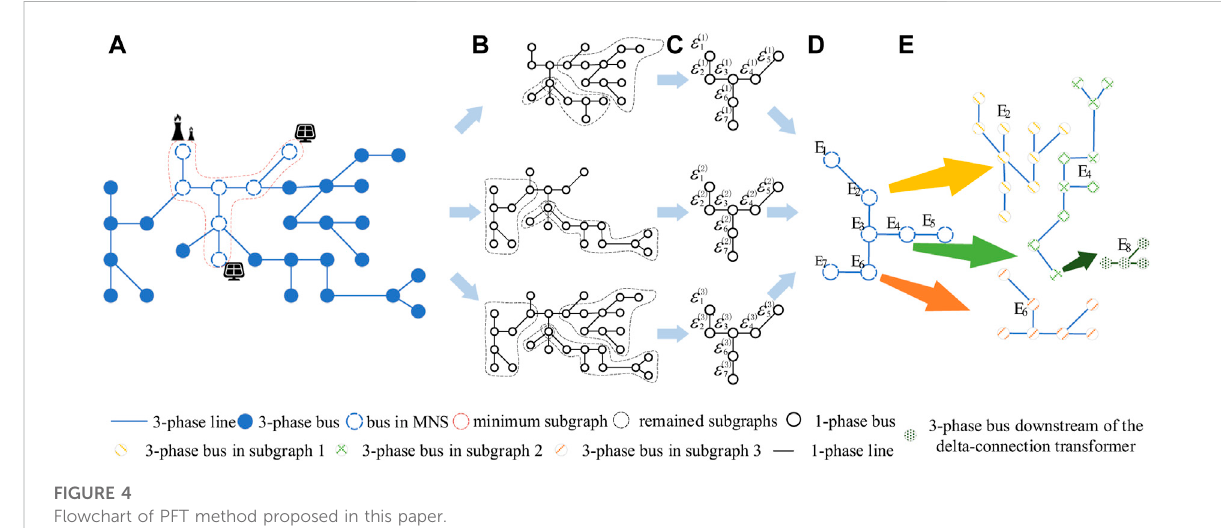
FIGURE 4 Flowchart of PFT method proposed in this paper.